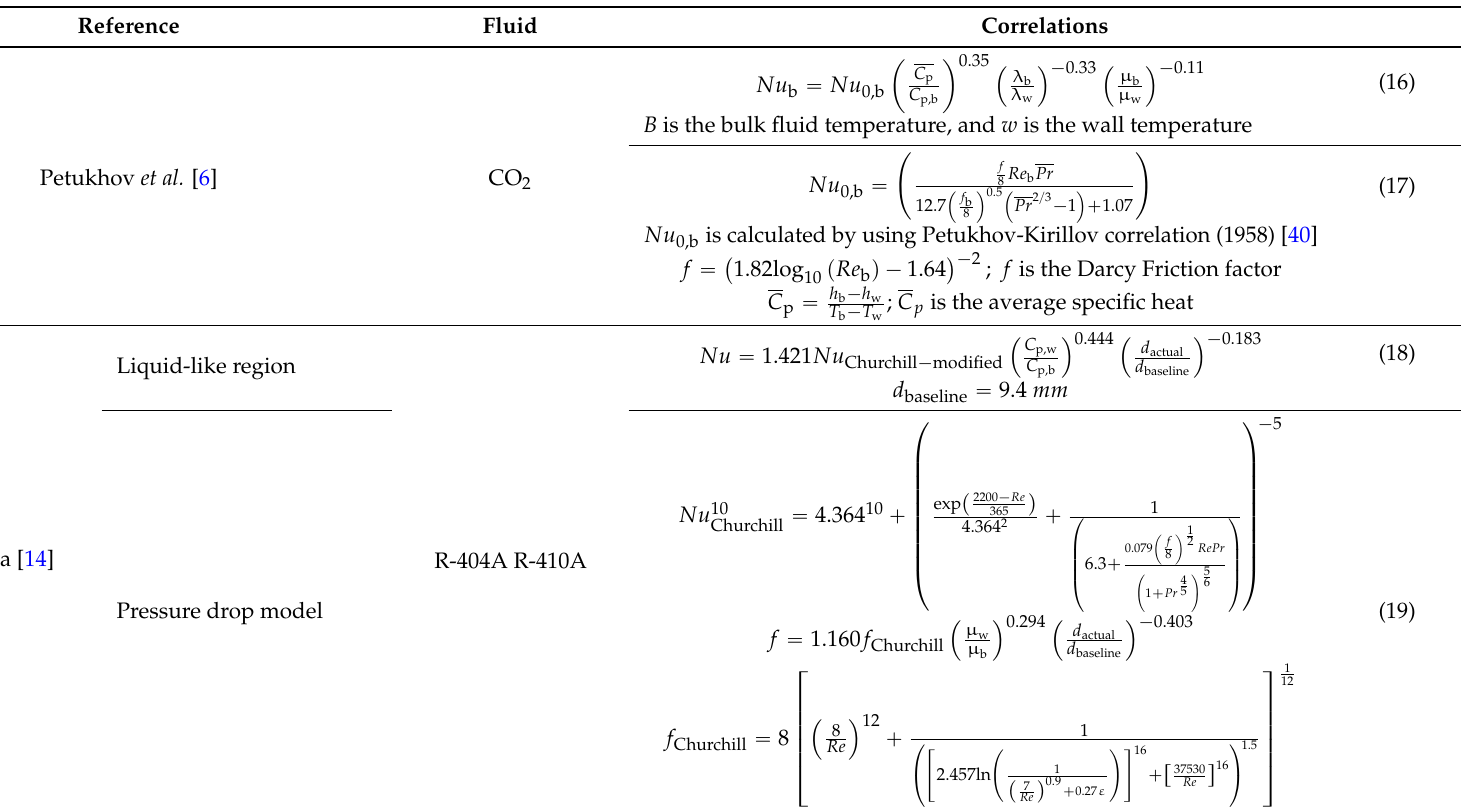
Table 4. Correlations for calculating the heat transfer coefficient at the coil